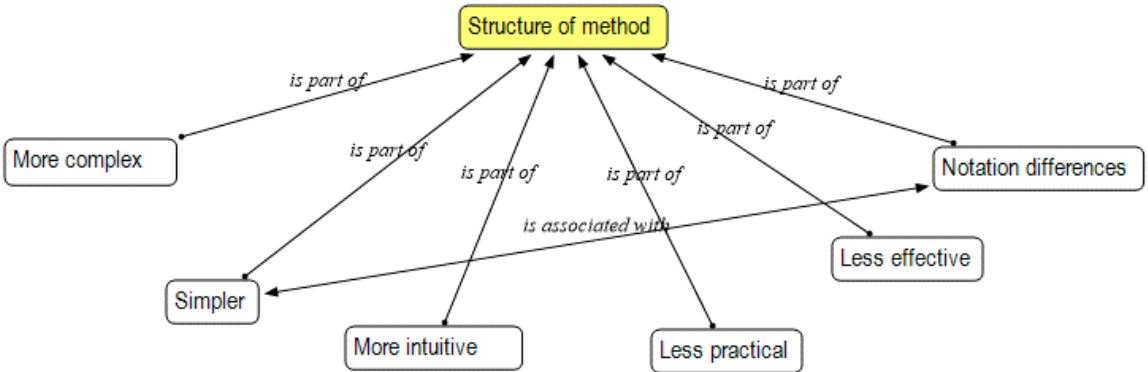
Figure 4. Category “structure of the method” reflecting the differences between the procedures in the historical multiplication methods (Egyptian and Russian peasants) and the modern-day one.